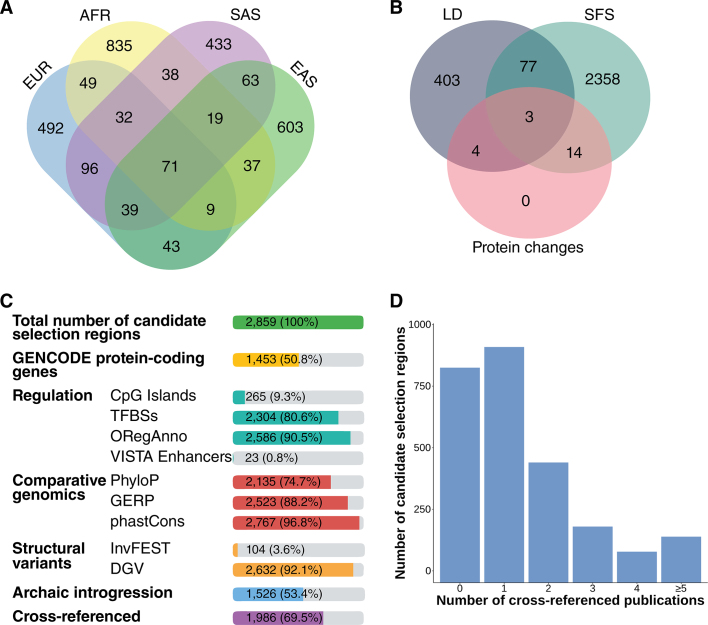
Summary of the contents of PopHumanScan. (A) Number of candidate regions under selection unique and shared among the four meta-populations: Europe (EUR), Africa (AFR), Sourth-Asia (SAS) and East-Asia (EAS). (B) Number of candidate regions under selection unique and shared among the three different signature types: Linkage Disequilibrium (LD), Site Frequency Spectrum (SFS) and Protein Changes. (C) Number of candidate regions under selection overlapping different structural and functional annotations. (D) Number of candidate regions under selection cross-referenced with 0, 1, 2, 3, 4 or ≥5 published papers.